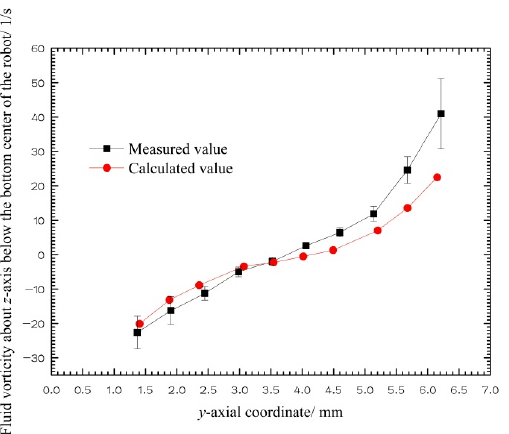
Figure 12. Fluid vorticity about the z -axis below the bottom center of the robot ( d = 18 mm, v = 0.05 m/s, n = 60 r/min, η = 0.02 Pa·s).